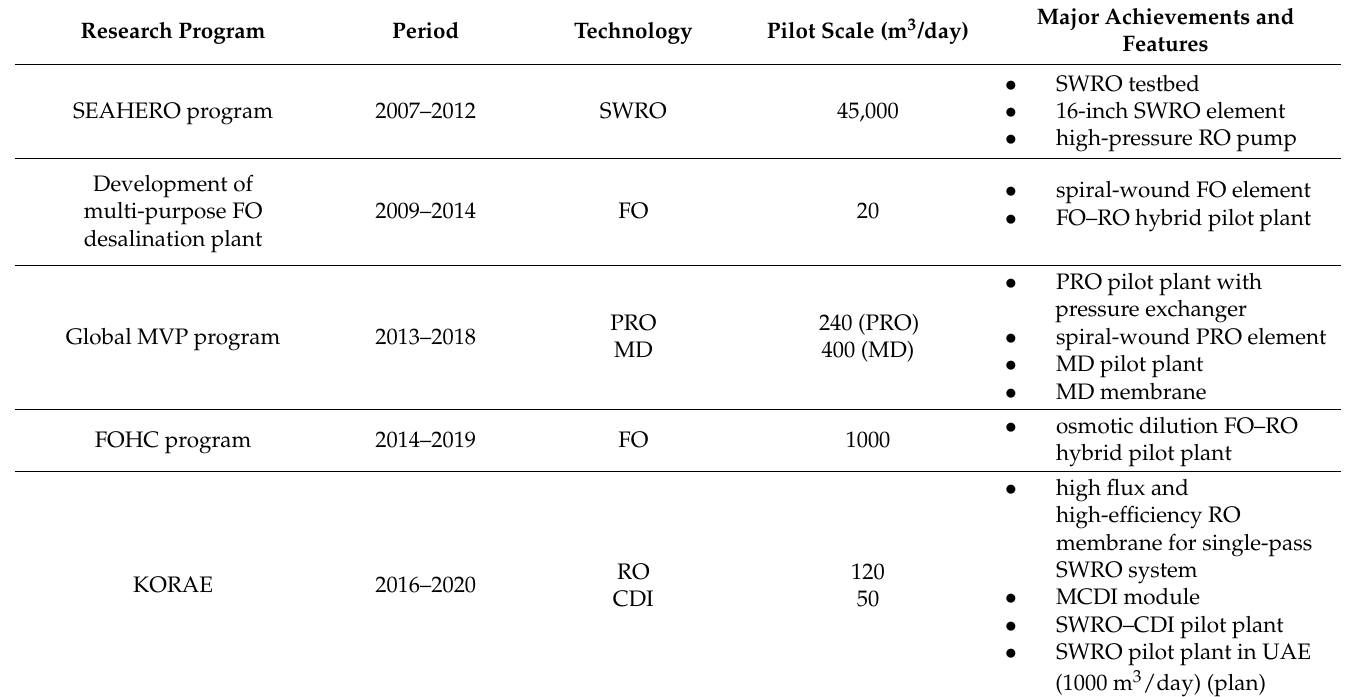
Table 4. Summary of representative desalination research programs and their pilot plants in South